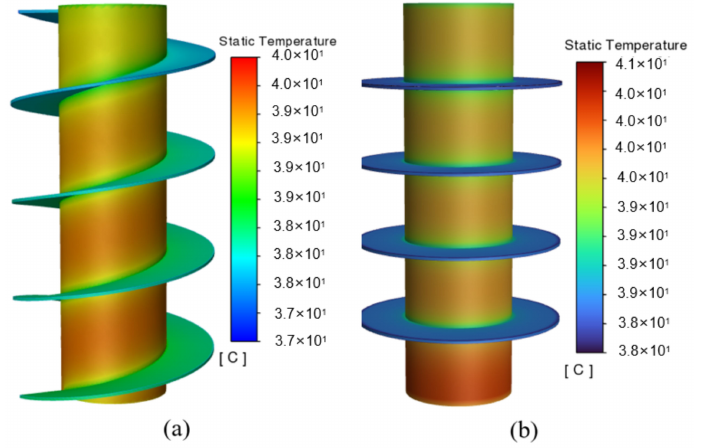
Figure 6. Temperature cloud diagrams of two kinds of PCM-fin systems: ( a ) spiral fins and ( b ) circular